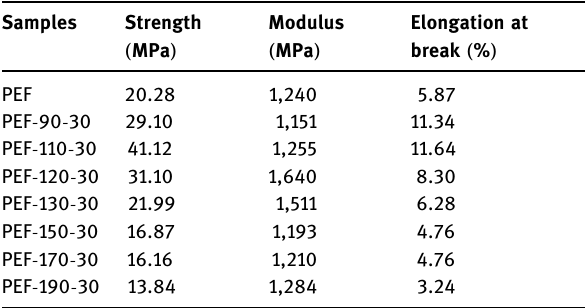
Table A2: Mechanical properties of PEF - T - 30 Samples